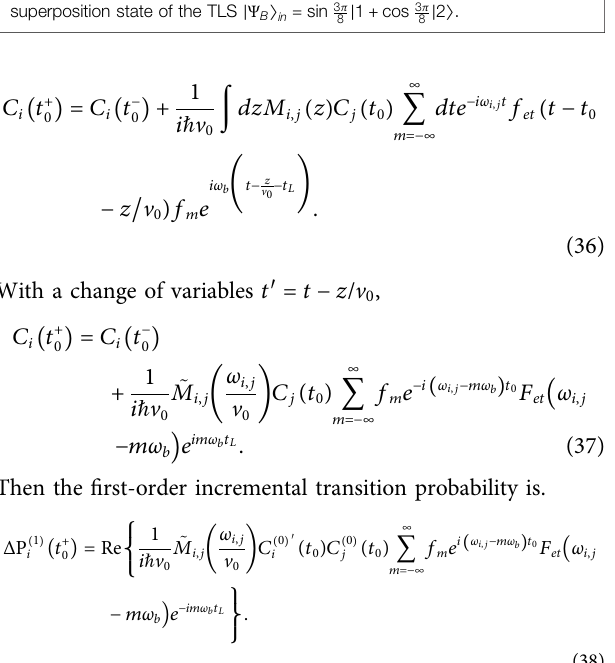
FIGURE 5 | (A) Density distribution of a broad QEW ( σ et / T 2 , 1 (cid:1) 1) (red broken line) and a modulated QEW having the same size envelope (blue continuous line). (B) Numerical computation results of the dynamics of the FEBERI interaction transition probability P 2 starting form ground state, based on the quantum model [solving the Schrodinger equation (1)] for the corresponding unmodulated and modulated QEWs. (C) The computed dynamics of the FEBERI interaction incremental transition probabilities for the same unmodulated and modulated QEWs, starting from a coherent | 1 + cos 3 π | 2 〉 superposition state of the TLS | Ψ B 〉 in (cid:1) sin 3 π 8 8